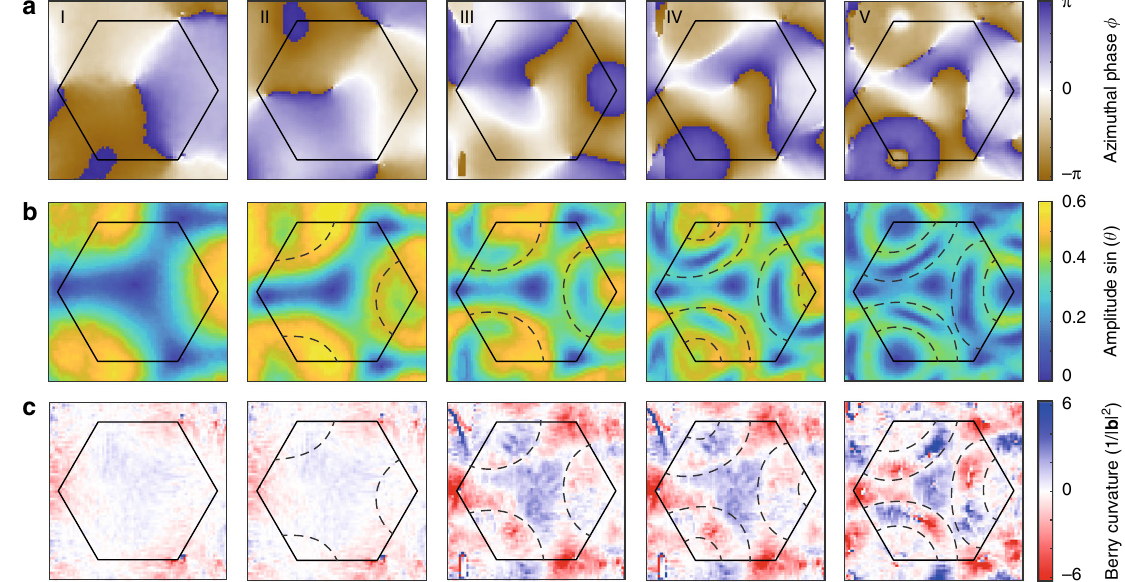
Fig. 5 Instantaneous Berry curvature and instantaneous Chern number. Data from time-resolved state tomography in the dispersive bands showing the azimuthal phase ϕ ( a ) and the amplitude sin ( θ ) ( b ) for different evolution times after the quench into a non-trivial system ( δ = − 2 π ⋅ 372 Hz). From these data, we obtain the instantaneous distorted Berry curvature ( c ) and the instantaneous Chern number of the time-evolved state in units of the inverse squared length of a reciprocal lattice vector b . The evolution times are 156, 273, 390, 507, and 663 μ s and the Chern numbers are − 0.001, − 0.008, − 0.013, − 0.016, − 0.015. Although the distorted Berry curvature develops fi ner structures as a function of time, the instantaneous Chern number stays zero, as enforced by the unitary evolution. The dashed lines separate regions, where the state lies on the southern and northern hemisphere